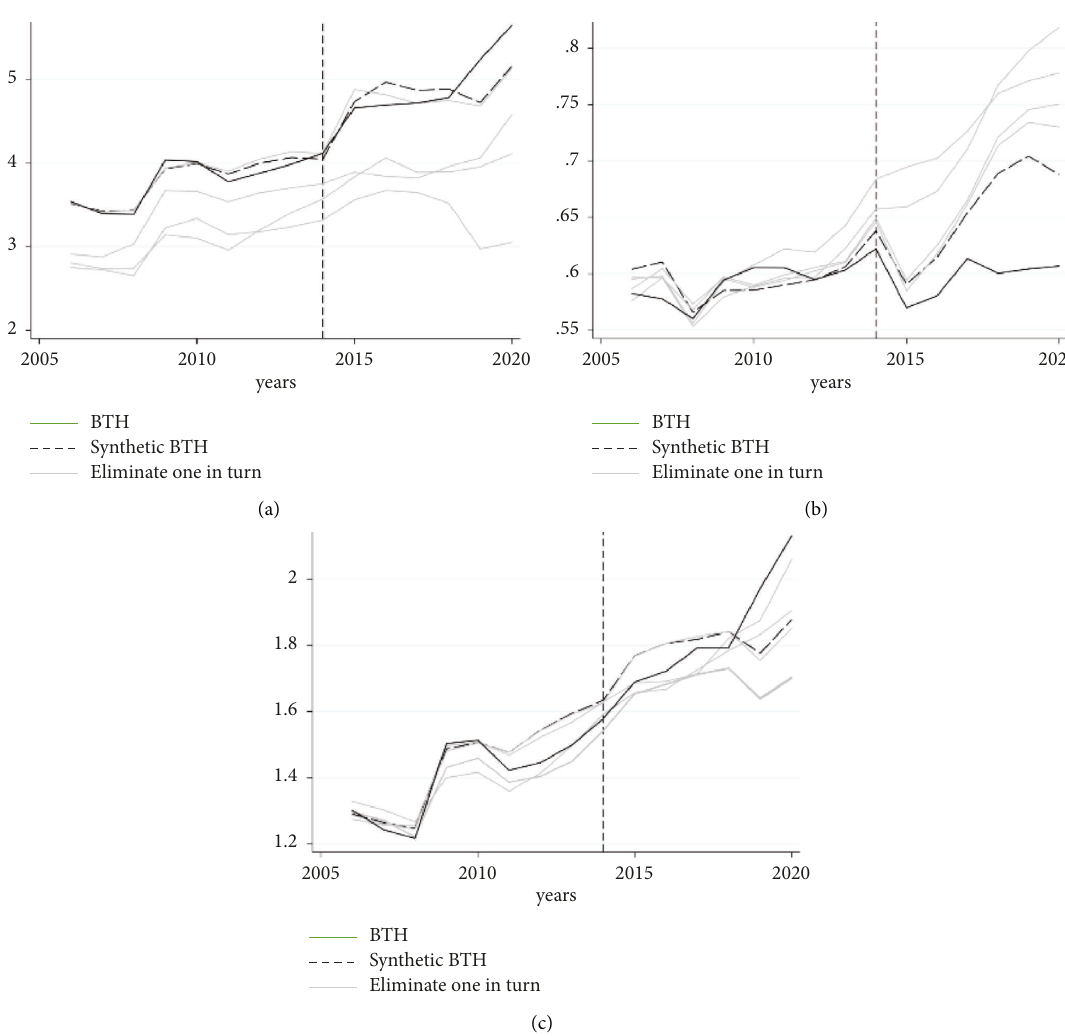
Figure 8: Sensitivity analysis: synthetic BTH for iterative removal of control group cities. (a) Financial scale. (b) Financial efficiency. (c) Financial